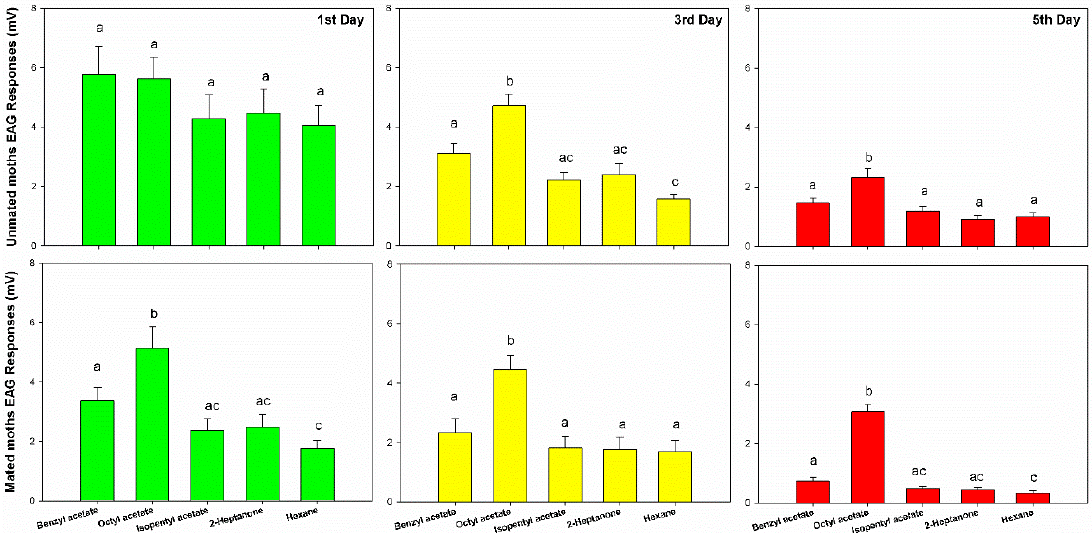
Figure 1. The electroantennogram responses of female moth (unmated moth n = 120, mated moth n = 120) to bee alarm pheromones (benzyl acetate, n = 60, octyl acetate, n = 60, isopentyl acetate, n = 60, 2-heptanone, n = 60) in 1st day ( n = 80), 3rd day ( n = 80) and 5th day ( n = 80) moths, error bars are presented with Mean ± SEM. Different letters indicate statistical significance in the bar graph.